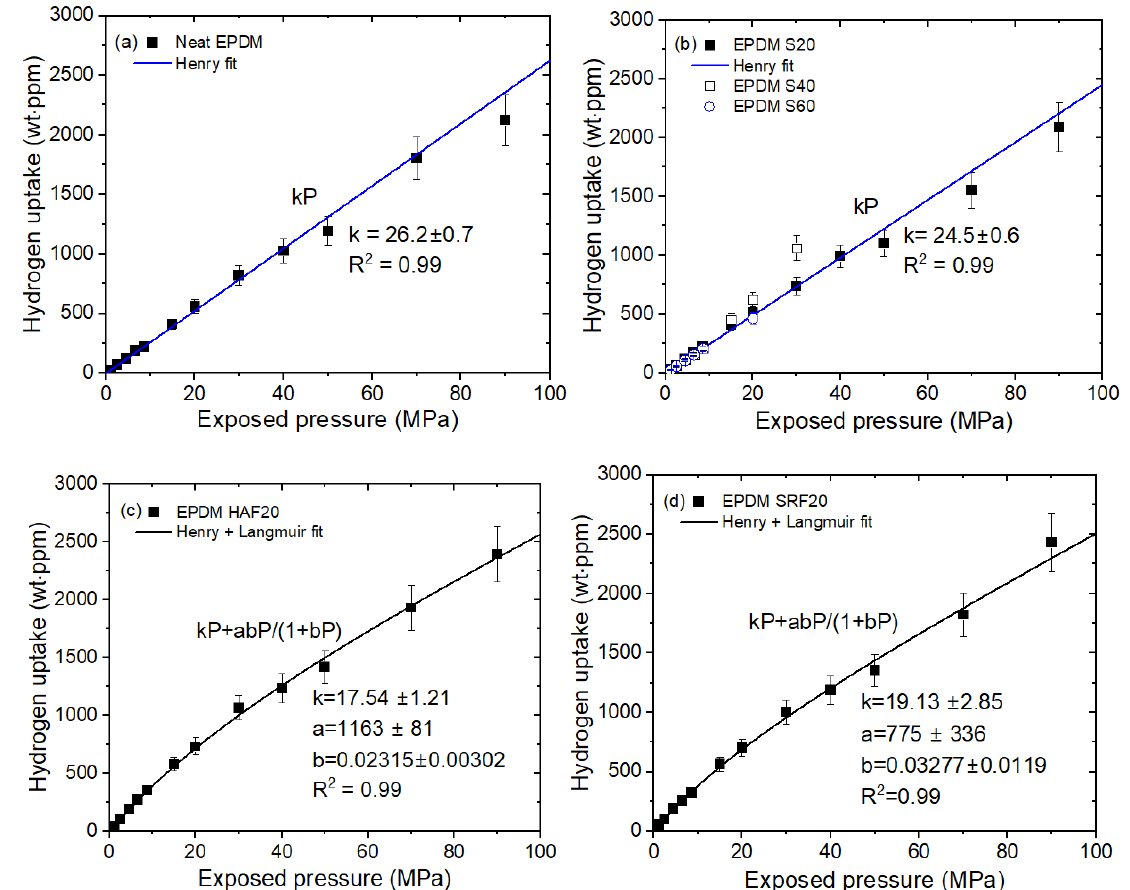
Figure 3. Relationship between H 2 uptake ( C ∞ ) and exposure pressure for ( a ) neat EPDM, ( b ) the EPDM S series, ( c ) EPDM HAF20, and ( d ) EPDM SRF20. The blue and black lines show the fits to the Henry model and the dual-mode (Henry and Langmuir) model, respectively. The legends show the least-squares fit equations and the correlation coefficient R 2 . Table 2. Fitting results with the sorption model for neat EPDM and the EPDM polymer filled with HAF CB, SRF CB, and silica fillers, according to Equation